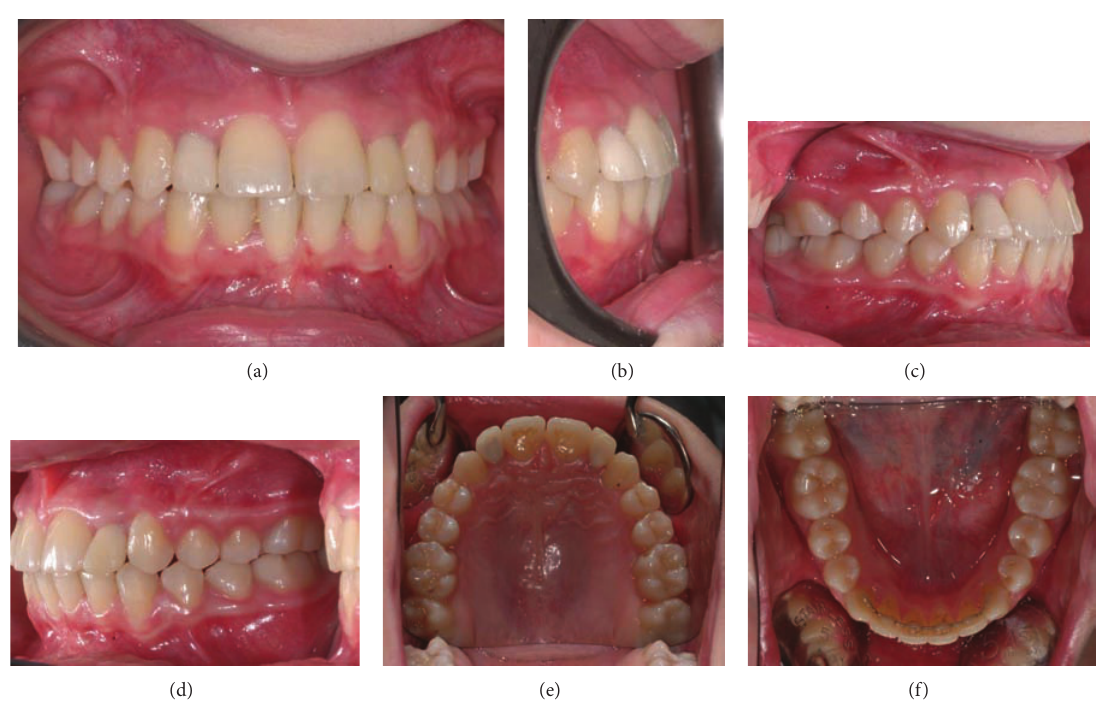
Figure 6: Intraoral photographs after prosthetic